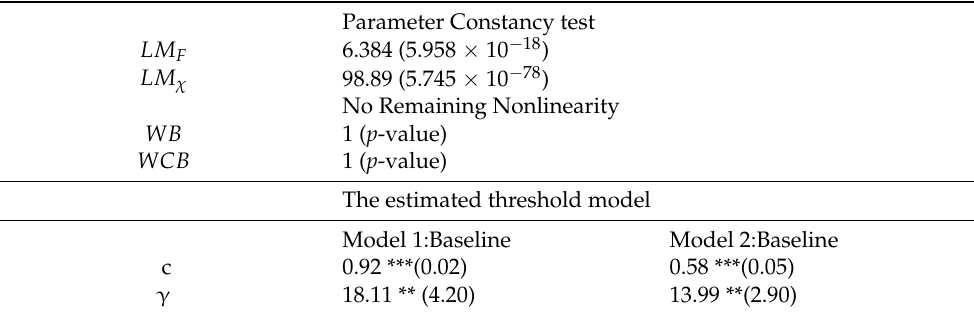
Table 2. Results of the evaluation test and the estimated